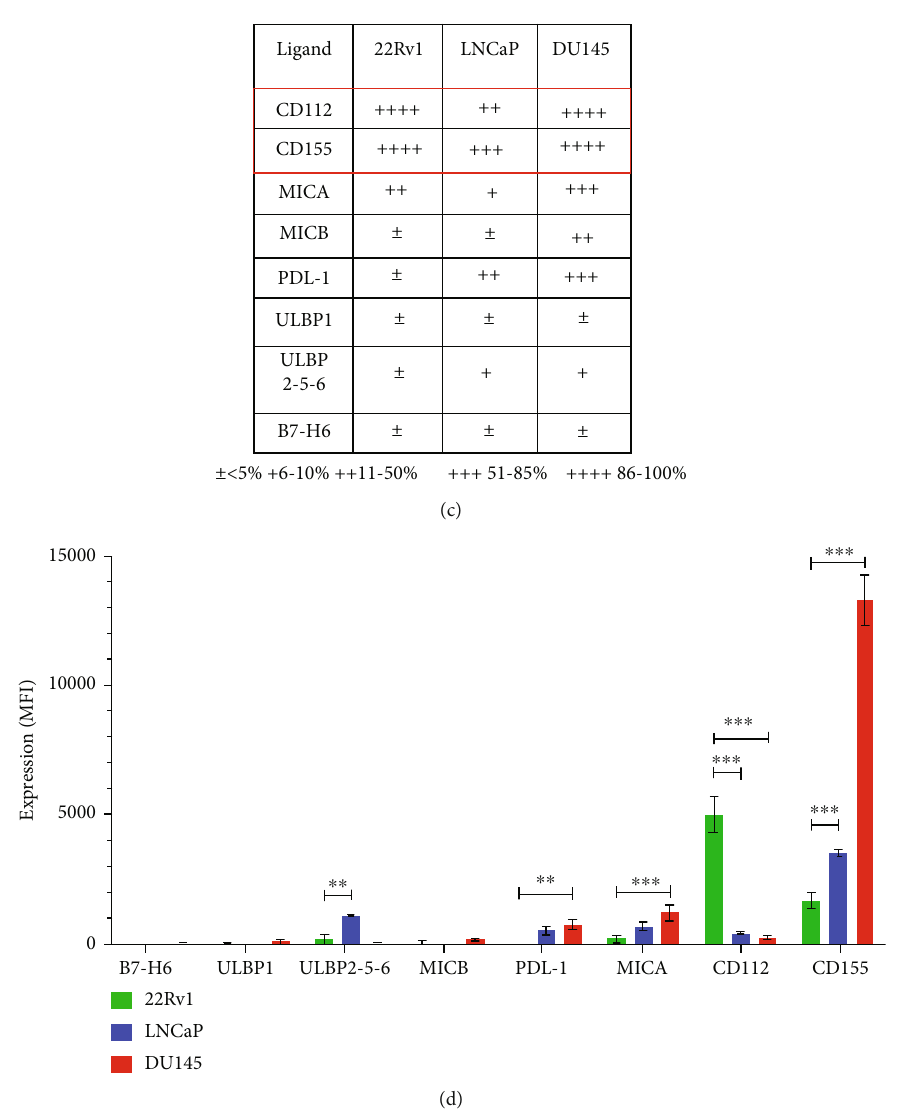
Figure 2: The expression of CD155 is increased in DU145 cells. The cells were cultured, and the expression of the ligands was subsequently evaluated by fl ow cytometry. (a) Ten thousand events from the region of the live cells were implemented for ligand evaluation. (b, c) The average percentage expression and (d) MFI of the ligands in the three PCa cell lines are shown. All experiments were repeated at least three times. Data are shown as the mean ± SD . ∗ p < 0 : 05 , ∗∗ p < 0 : 01 , ∗∗∗ p < 0 : 001 (ANOVA with Tukey ’ s multiple comparison